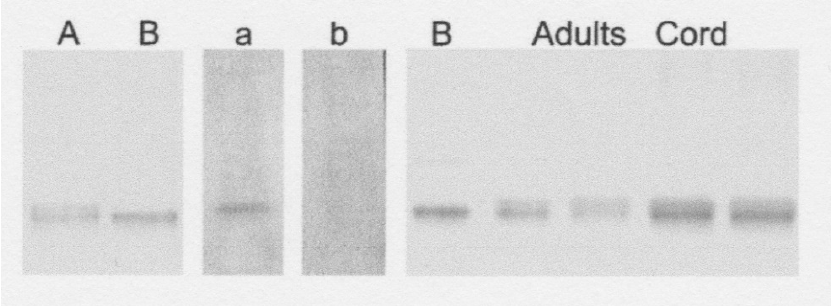
Figure 5. Native PAGE of human serum before and after removal of most of the copper by dialysis against NaCN, to form apoceruloplasmin. Left to right: immunoblot, with antibody against ceruloplasmin, A—before, and B—after Cu removal; in situ staining for ceruloplasmin oxidase activity, a—before, and b—after NaCN dialysis; immunoblot of apoceruloplasmin-rich plasma (B), 2 lanes each of normal adult human plasma and cord blood. Gel was 8% acrylamide, and resolving buffer was pH 7.4. Reprinted with permission from Hirano et al. [29].